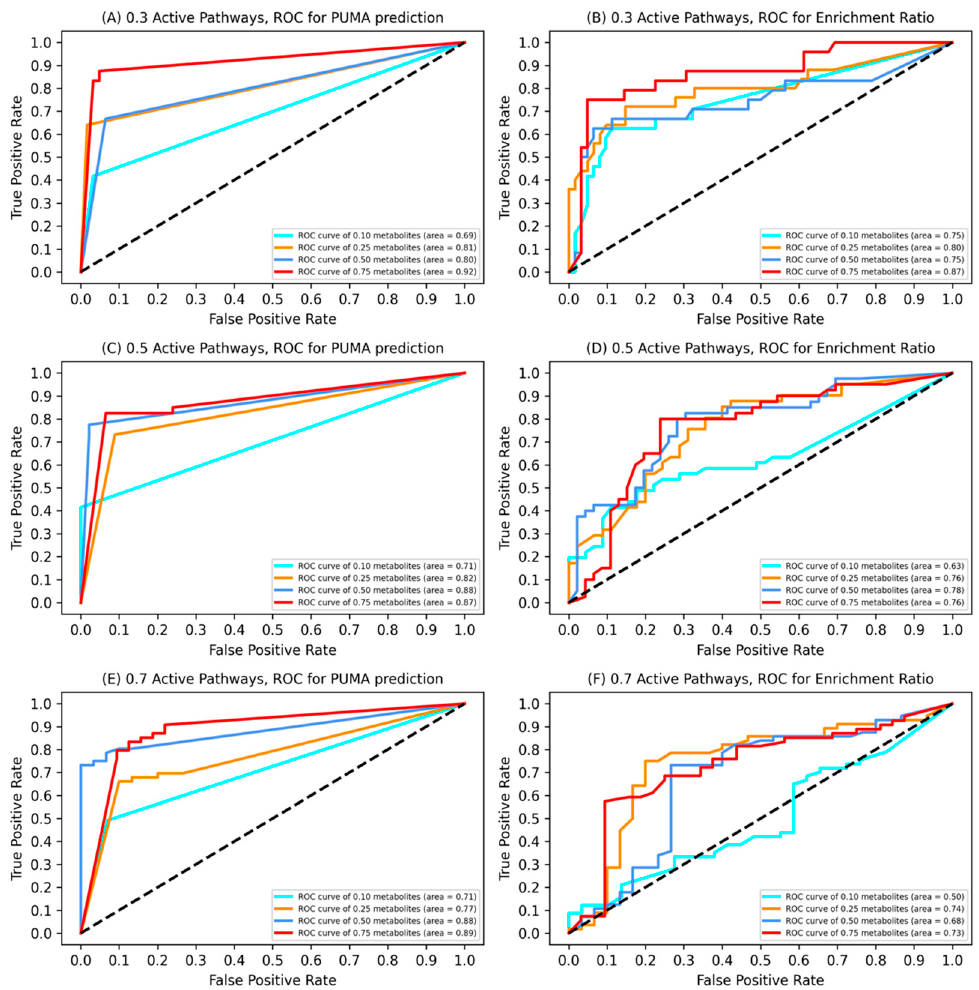
Figure 4. AUC for ROC curves for the synthetic datasets under different assumptions regarding pathway activity and metabolite generation. ( A , C , E ) PUMA. ( B , D,F ) Enrichment ratio.